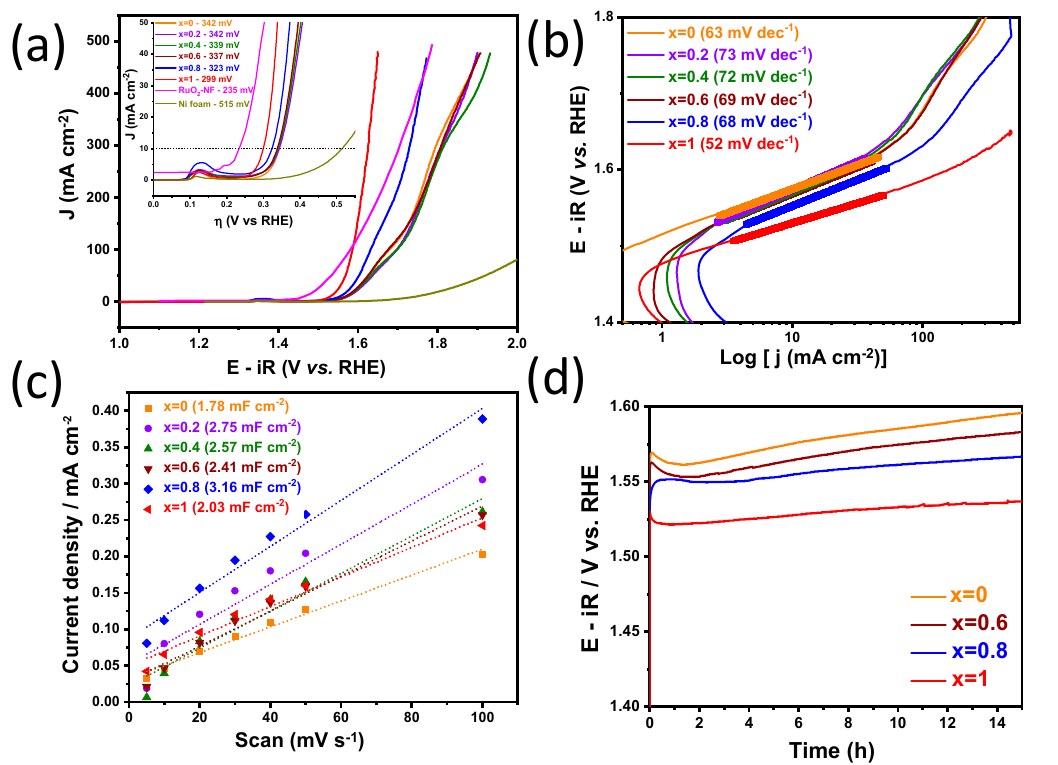
Figure 11. ( a ) LSV collected at 5 mV s − 1 in 1 mol L − 1 KOH for Mn X Co 3-X O 4 (0 ≤ X ≤ 1) electrodes, where X = 0.0, X = 0.2, X = 0.4, X = 0.6, X = 0.8, and X = 1.0, and ( b ) the corresponding Tafel slopes; ( c ) anodic current (i a ) versus scan rate to determine CDL; ( d ) chronopotentiometry analysis measured at 10 mA cm − 2 Table 5. Comparison of OER performance of nanostructured Mn X Co 3-X O 4 (0 ≤ X ≤ 1) catalysts reported in the literature. Data refer to an overpotential to generate j = 10 mA cm 2 ( ƞ 10 ).